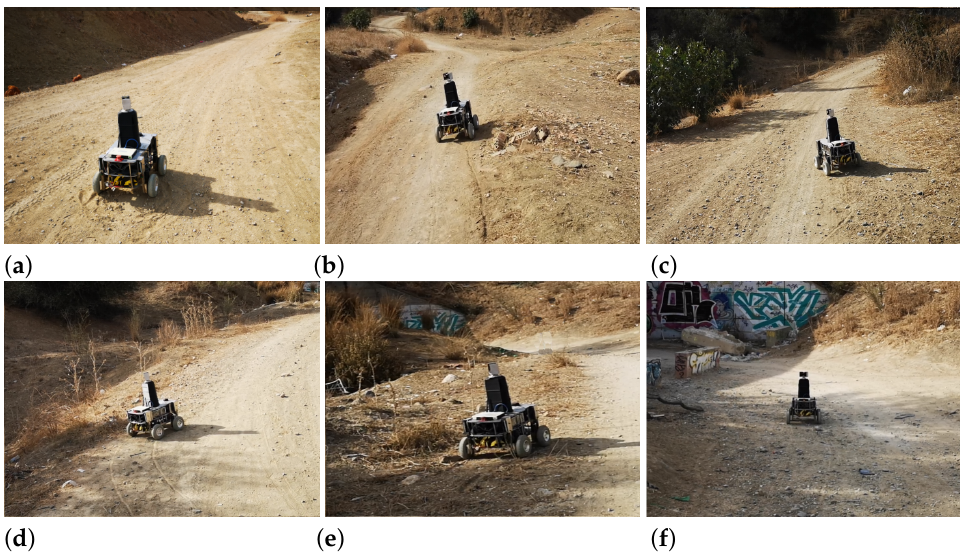
Figure 19. Photographs of Andabata during the autonomous navigation test at the spots indicated in Figure